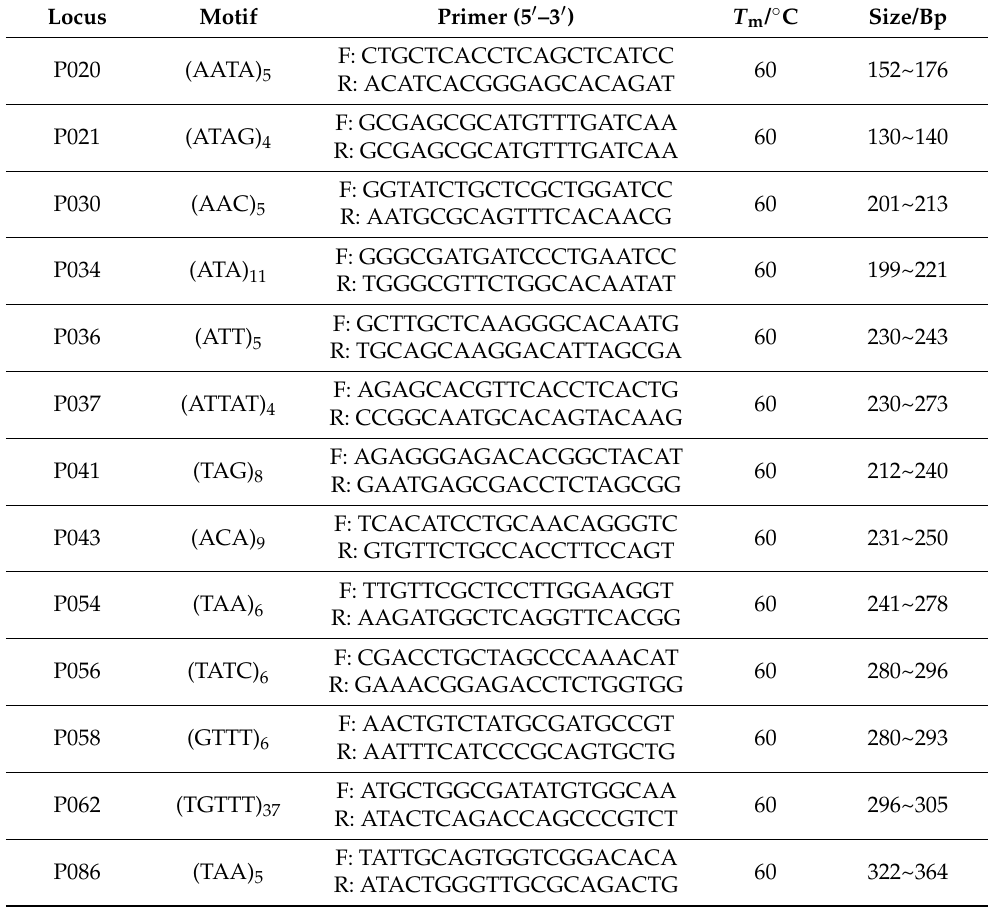
Table 2. Information of SSR markers analyzed in this study from H. molitrix . Locus